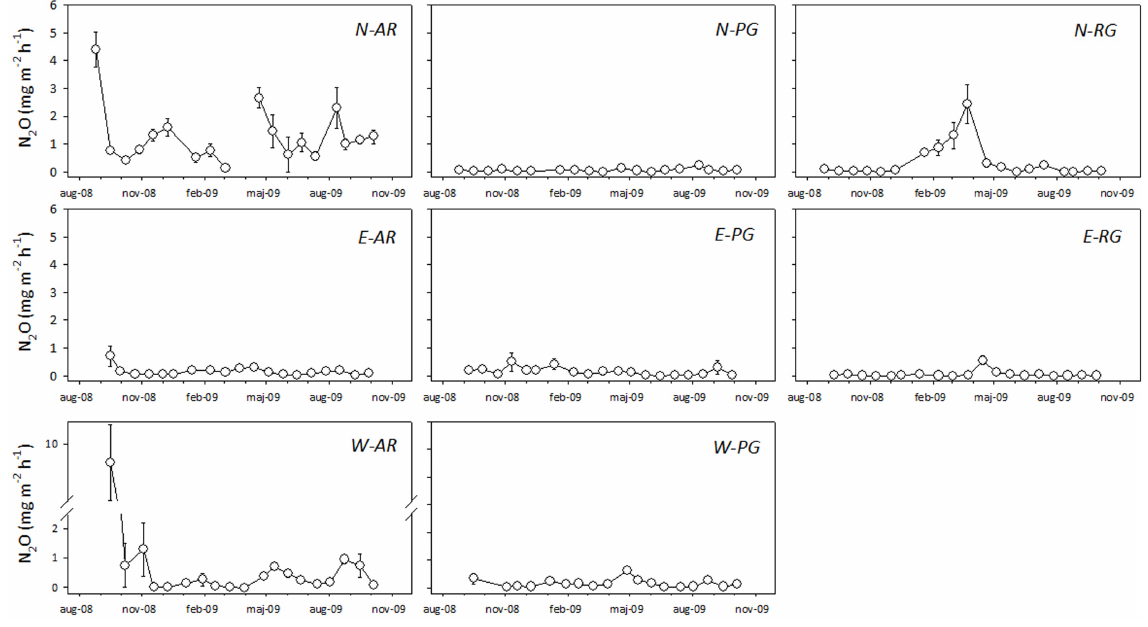
Fig. 7. Seasonal variations in N 2 O fluxes at the eight monitoring sites; for information about site ID, see legend to Fig. 2. One data set from April 2009 at site N-AR was omitted due to unresolved analytical problems. The data represent mean ± standard error ( n = 6).